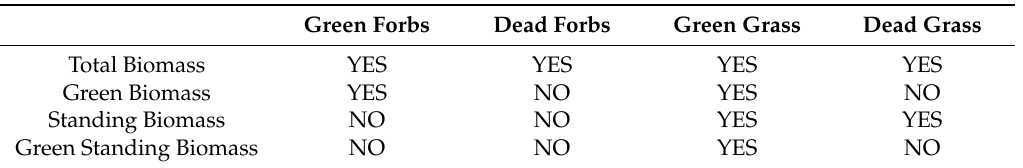
Table 1. The vegetation types included in each category of harvested biomass. Graminoids are designated “grass” and non-graminoids are designated “forbs.” Green Forbs Dead Forbs Green Grass Dead Grass Total Biomass